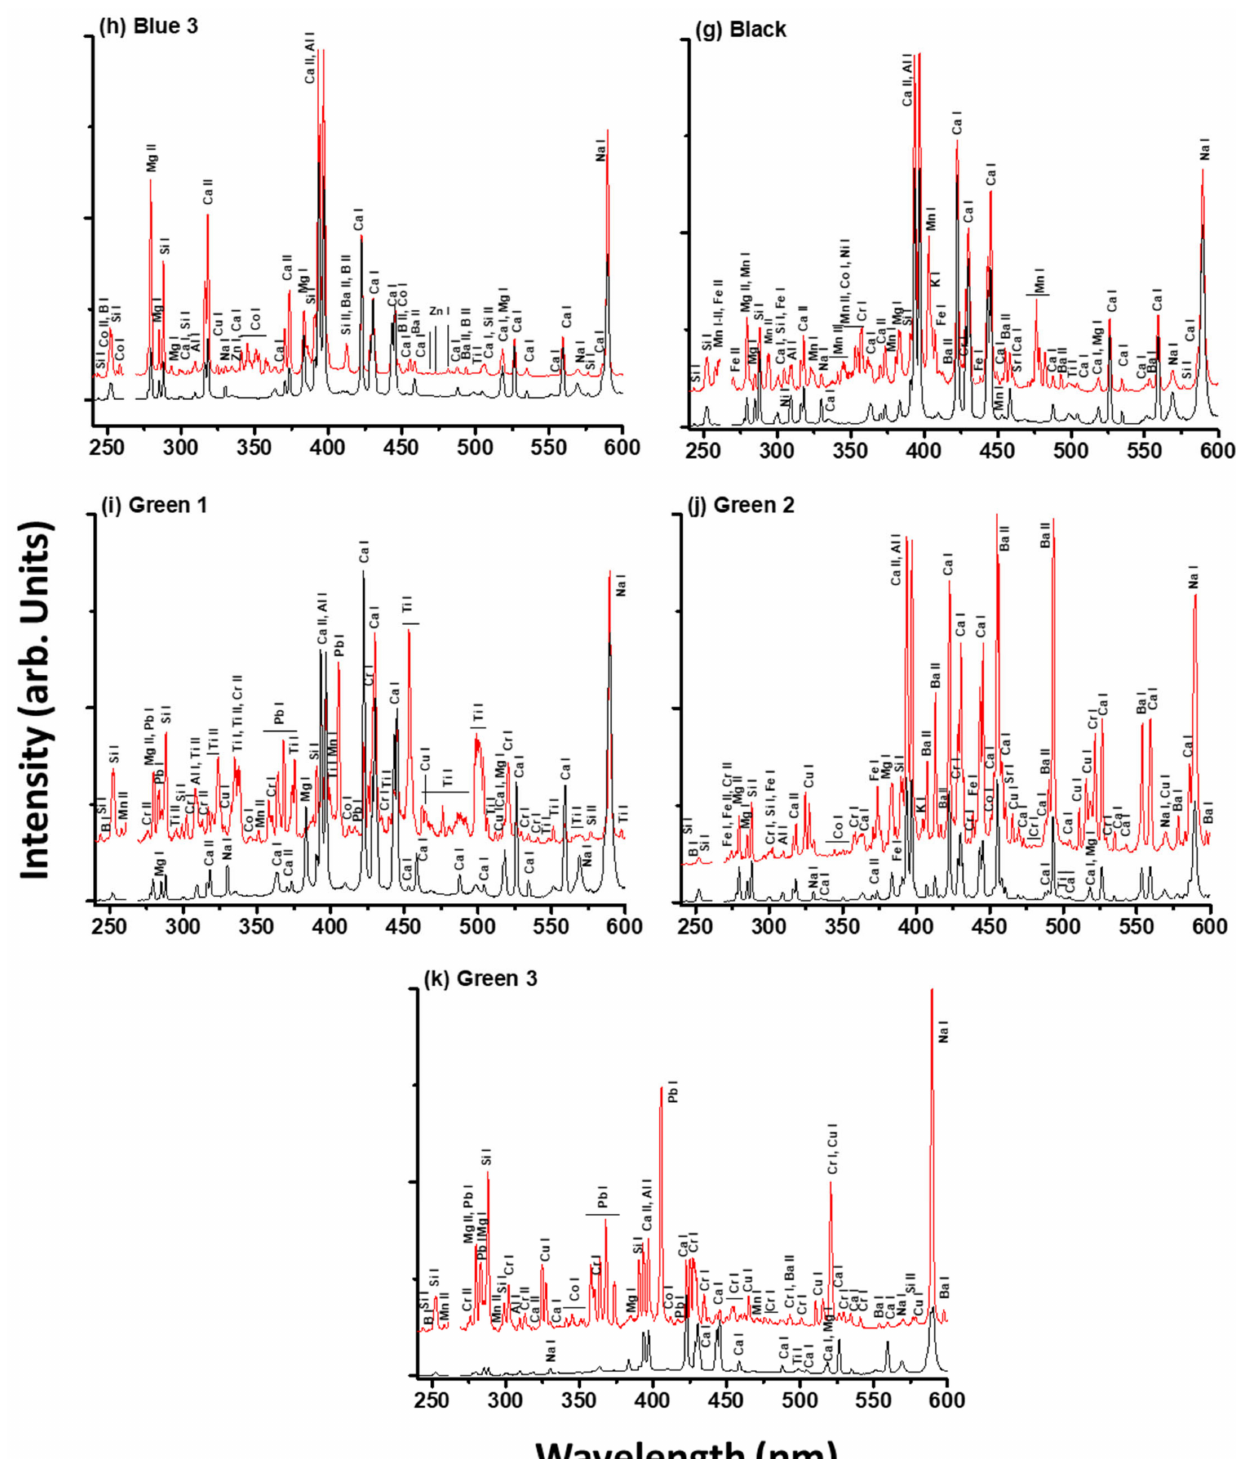
Figure 5. LIB spectra of base glass (lower black spectra) and colored layers (upper red spectra) from flashed glasses. The assigned neutral (I) and ionic (II) atomic lines are indicated. The gap at wavelengths between 260 and 270 nm has been intentionally left to avoid the scattering light from the excitation laser at 266 nm. ( a – k ) correspond to LIBS spectra of samples Pink1, Pink2, Brown1, Brown2, Blue1, Blue2, Blue3, Black, Green1, Green2 and Green3,